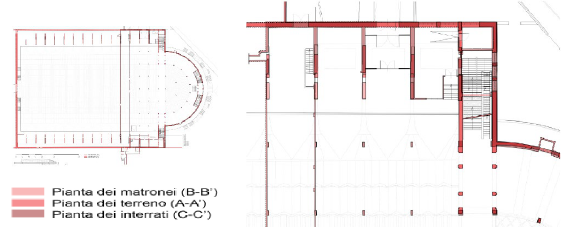
Figure 3 . Overlay of architectural drawings based on topographical reference of the underground, ground and galleries levels of the building (a) overall (b)